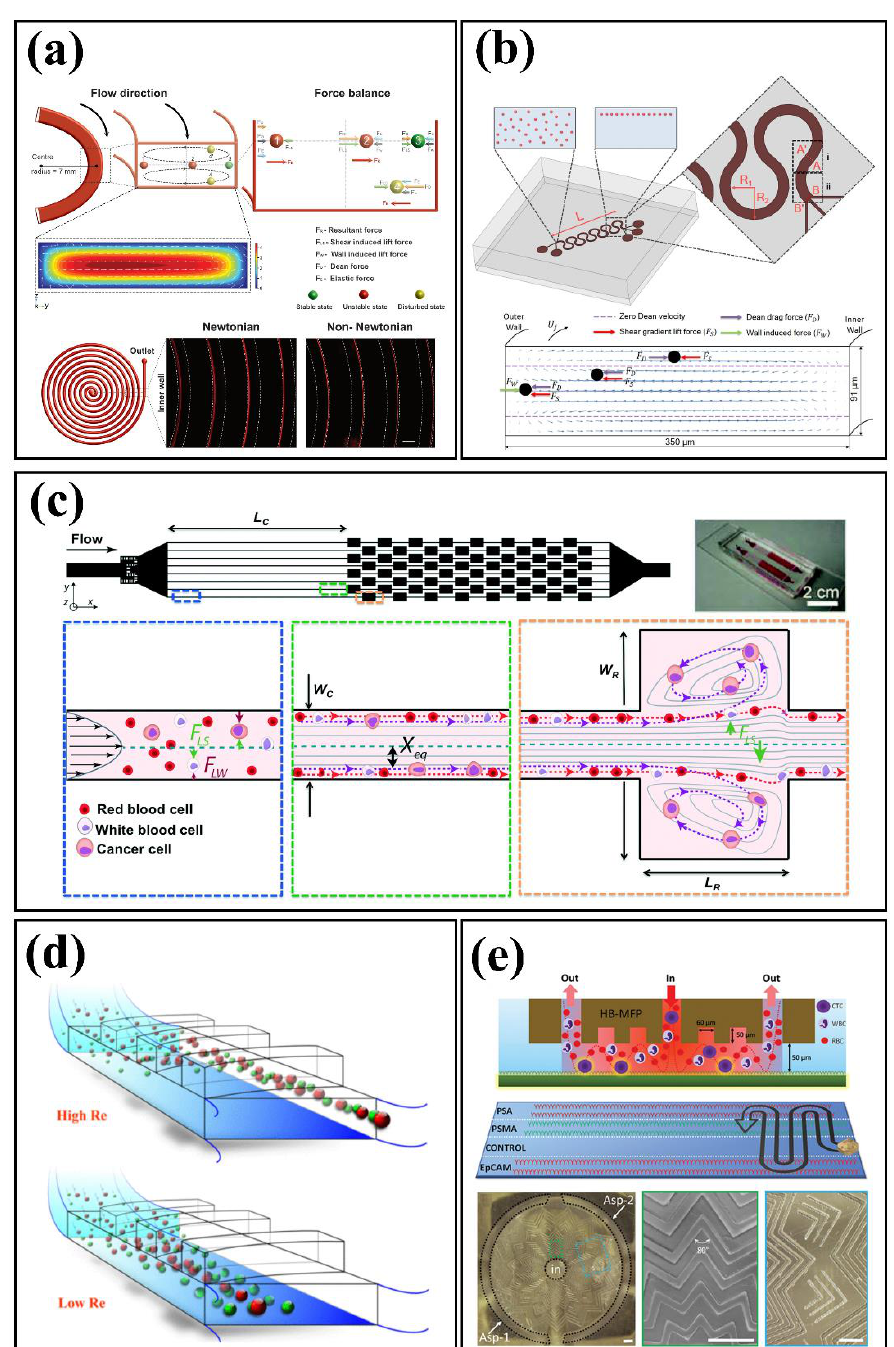
Figure 3. Inertial and secondary flow examples: ( a ) viscoelastic non-Newtonian spiral device, reprinted with permission from [44], Copyright 2021, Springer Nature; ( b ) serpentine device, reprinted with permission from [1], Copyright 2016, Springer Nature; ( c ) successive contraction and extraction channels, reprinted with permission from [38], Copyright 2013, Royal Society of Chemistry; ( d ) top surface slanted grooves configuration, reprinted with permission from [39], Copyright 2017, IEEE; and ( e ) Herringbone structure, reprinted with permission from [40], Copyright 2021, Wiley‑VCH